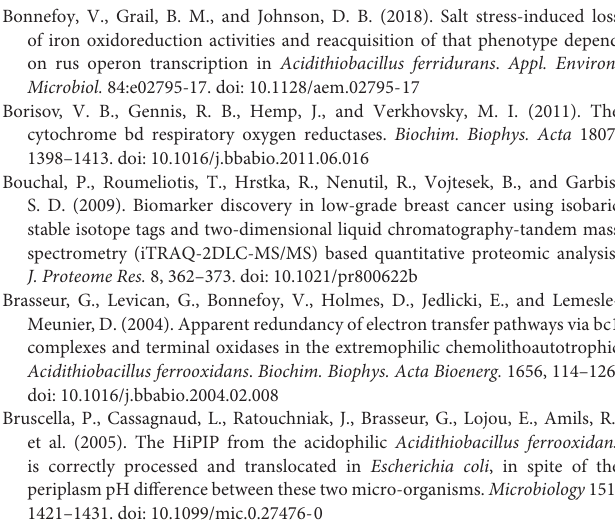
Supplementary Table 1 | List of all quantified peptides in DIA-MS proteomics analysis. Supplementary Table 2 | List of all quantified proteins in DIA-MS proteomics